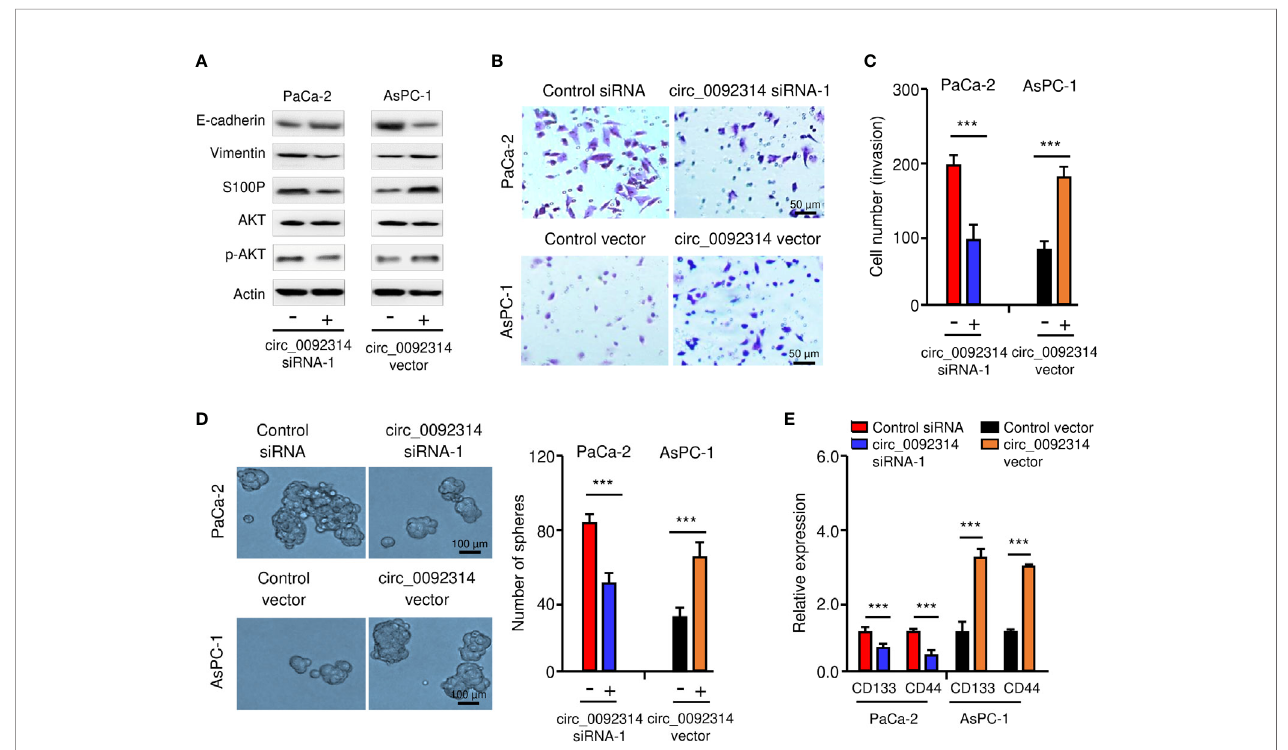
FIGURE 3 | Circ_0092314 induces EMT in PAAD cells. (A) Western blotting analysis of the indicated proteins in circ_0092314-silenced or circ_0092314- overexpressing PAAD cells. (B, C) Images of representative invasive PAAD cells are shown ( B ), and quanti fi cation analysis is presented (C) . (D) Tumor sphere formation assay for circ_0092314-silenced or circ_0092314-overexpressing PAAD cells, shown by representative images (left) and by quanti fi cation (right). (E) qRT- PCR assay of CD133 and CD44 expression in circ_0092314-silenced or circ_0092314-overexpressing PAAD cells. *** P